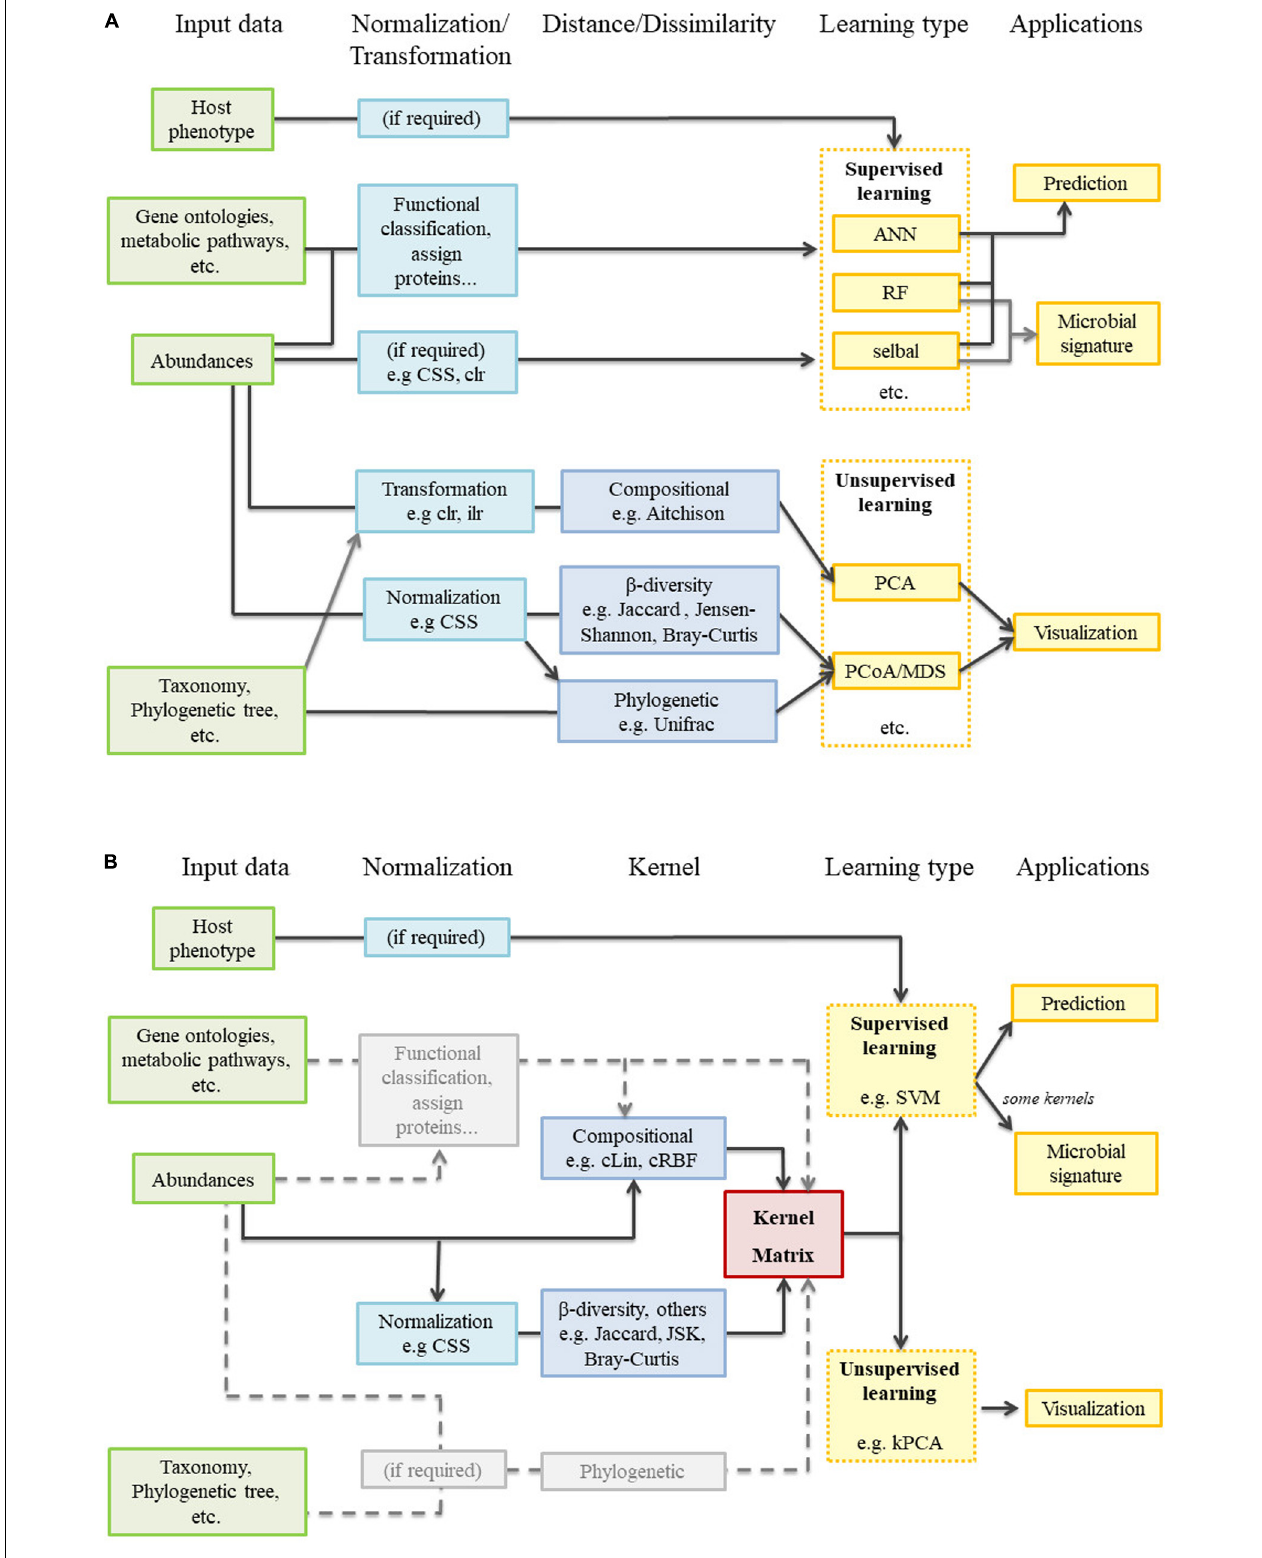
FIGURE 1 | Metagenomic analysis workflow. (A) Current state-of-the art: supervised and unsupervised learning are completely independent. (B) Kernel framework: the pivotal position of the kernel matrix is clearly observed. In gray, several tasks not performed during the present work but that merit future research.